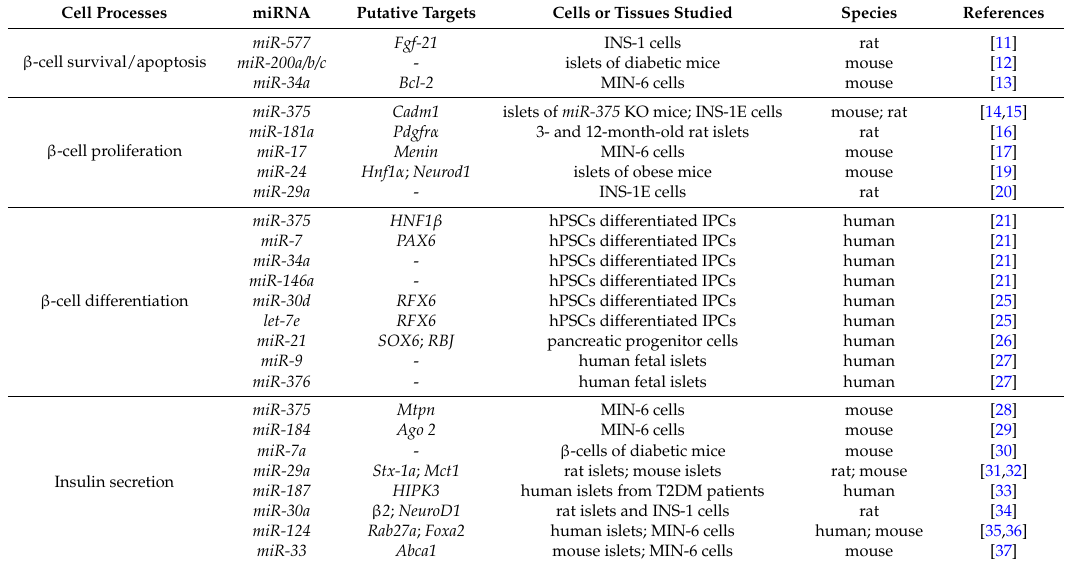
Table 1. Principle microRNAs (miRNAs) involved in pancreatic β -cell function.